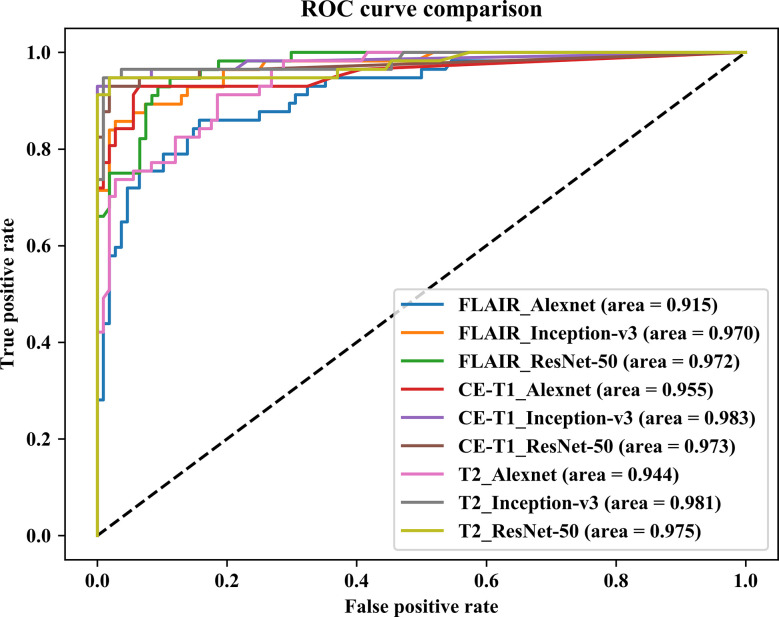
Comparison of receiver operating characteristic curves of three pretrained CNN models based on three single MRI modalities.